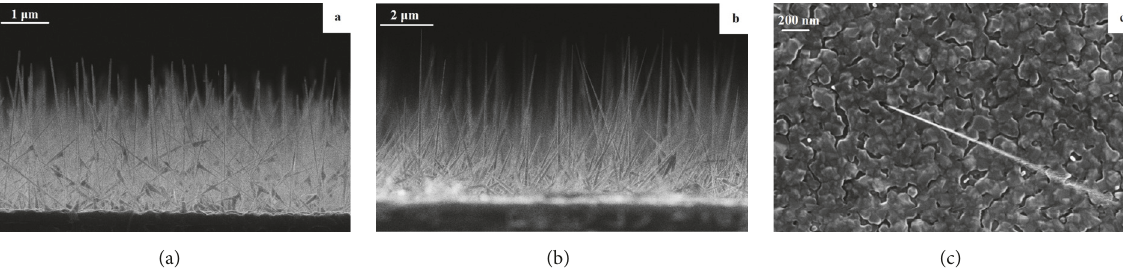
Figure 7: SEM images of A 3 B 5 NWs grown on SiC/Si(111) substrate: (a) GaAs NWs (cross-sectional); (b) AlGaAs NWs (cross-sectional); (c) InAs NWs (top